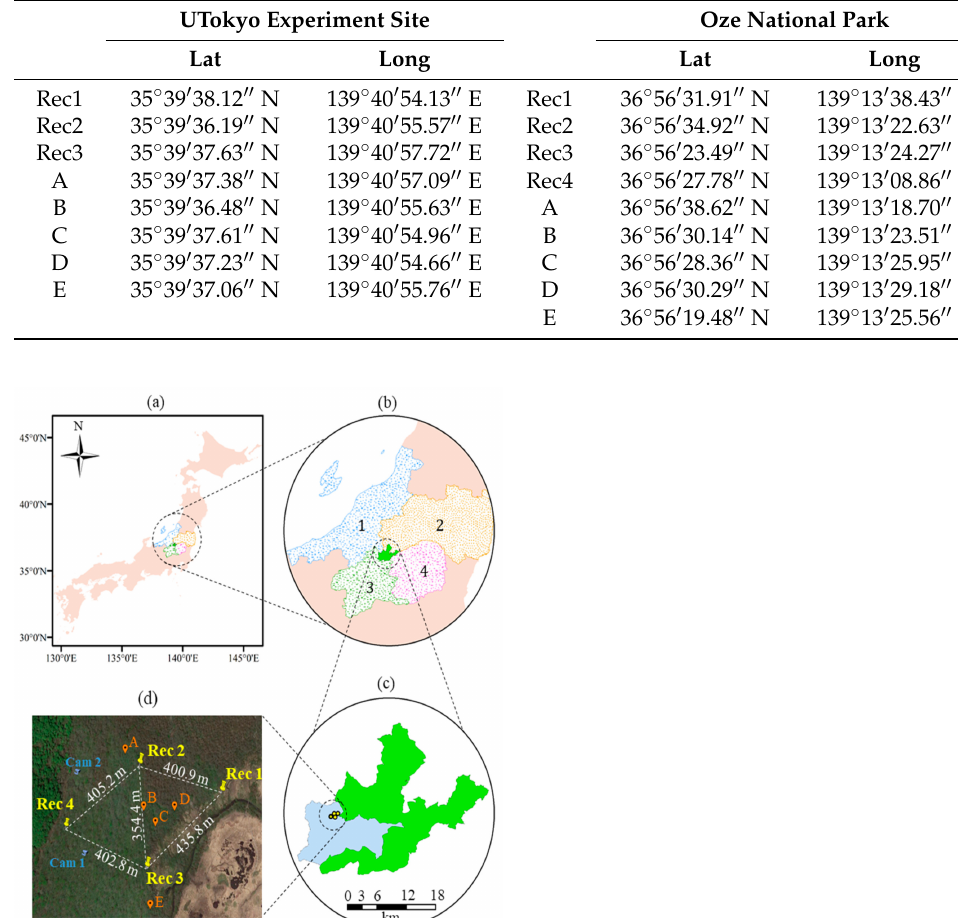
Figure 1. ( a ) First validation experiment site conducted on 29 November 2017 at University of Tokyo, Japan, and ( b ) location of the three recorders (i.e., Rec 1–3) and validation points (i.e., A–E) where deer calls were emitted using a deer whistle. Playground image from Google Earth. Table 1. Coordinates of recorders (Rec 1–4) and validation points (A–E) where deer calls were emitted using a deer whistle at University of Tokyo experiment (Figure 1b) and Oze marshland (Figure 2d).